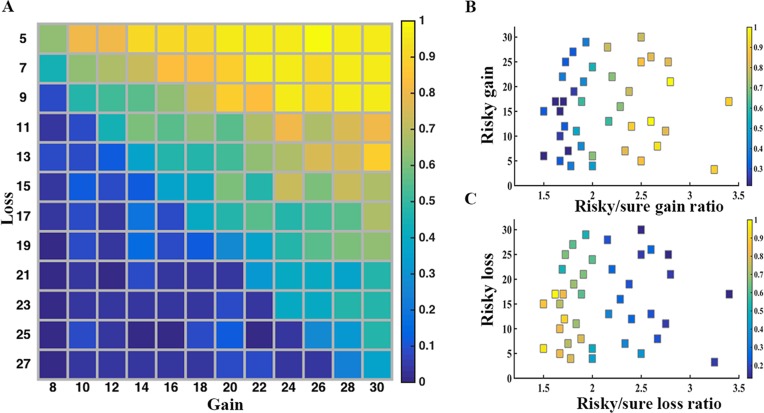
Choice sets and average percentage of risky choices across subjects.(A) In 144 mixed gambles, potential gains and losses of the gamble were orthogonalized by design, with gains ranging from ¥8 to ¥30 (increments of ¥2) and losses from ¥5 to ¥27 (increments of ¥2). Subjects were sensitive to both gains and losses in the risky option. (B) In 40 gain only trials, the sure gain ranged from ¥1 to ¥15 and the risky gain ranged from ¥3 to ¥30, resulting the risky/sure gain ratio from 1.5 to 3.4. As this ratio increased, subjects were more likely to select the risky option (warmer color dots on the right). (C) In 40 loss trials, the signs of gamble and sure option amounts were flipped as opposed to the gain trials. Subjects were less likely to commit to the gamble as the risky/sure loss ratio increased. Color bar indicated the percentage of subjects choosing risky choices.